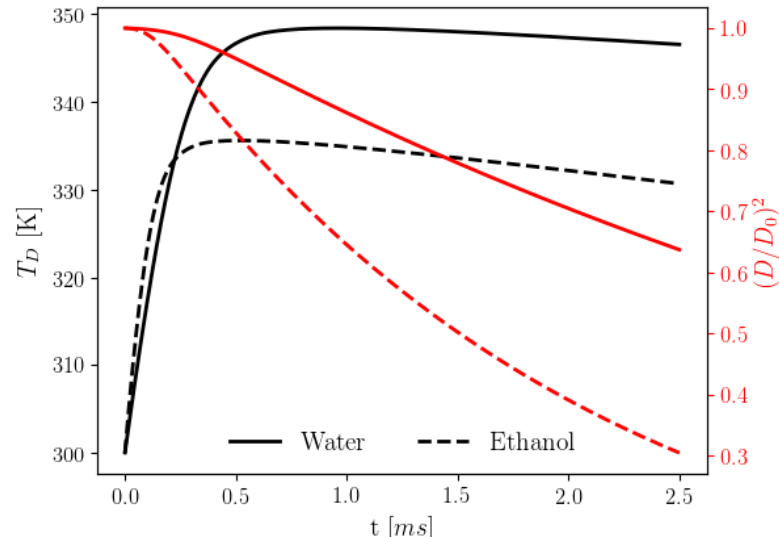
Figure 7. Temporal evolution of the droplet temperature, left axis and black lines, and the normalized surface area, right axis and red lines, for water (solid lines), and ethanol (dashed lines). R D = 10 µ m , I L 0 = 10 10 W/m 2 , the continuous laser heating